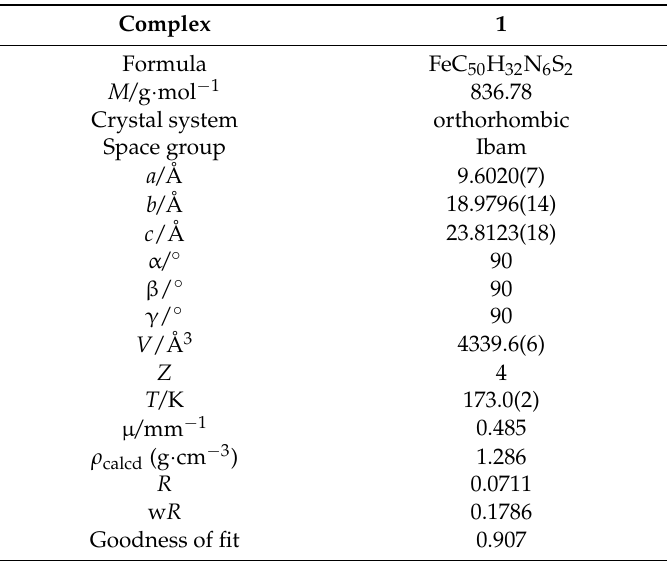
Table 2. Crystallographic data for complex 1.